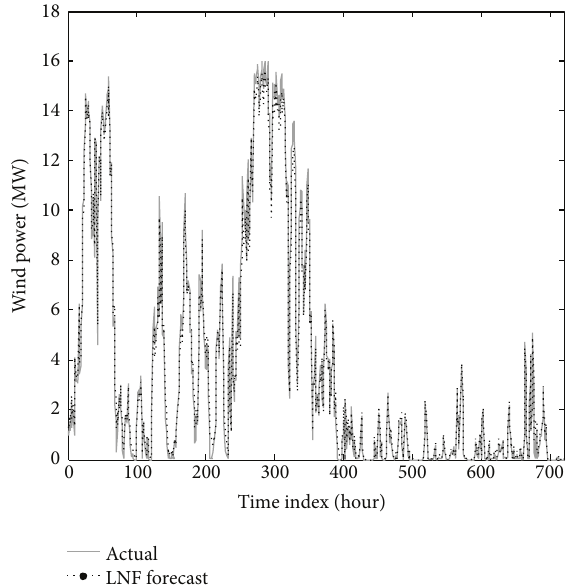
Figure 7: Actual and forecasted wind power for April